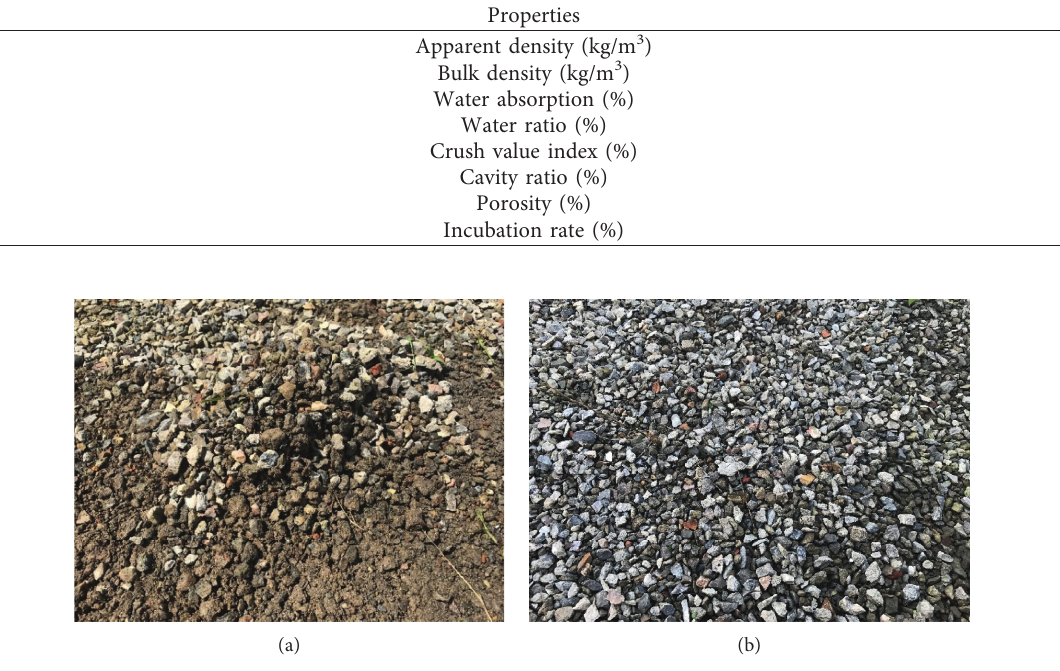
Figure 2: Recycled coarse